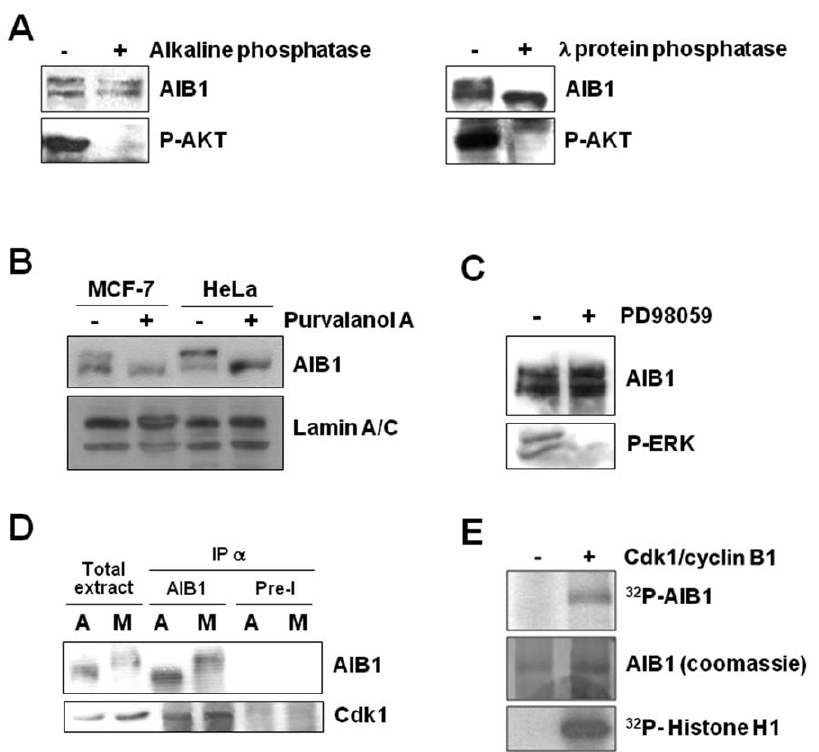
Figure 3. AIB1 is phosphorylated at entry to M phase by Cdk1/cyclin B. (A) Western blot analysis of 30 m g of cleared lysates from nocodazole-arrested HeLa cell which were treated with the indicated phosphatases for 1.5 h at 30 u C. Phospho-Akt antibodies were used as a control of the enzymatic activity. (B) Cells arrested at mitosis with nocodazole were further treated with vehicle alone ( 2 ) or with the Cdk1 inhibitor purvalanol A 10 mM ( + ) during 3 hours. Anti-lamin A/C antibodies were used to control loading. (C) Mitotic cells were treated with the MEK inhibitor PD98059 20 m M ( + ) or with vehicle alone ( 2 ) and cell lysates were analyzed by western blotting with AIB1 antibodies. Phospho-ERK specific antibodies were used as control for the efficiency of the treatment. (D) Western blot analysis of immunoprecipitated complexes using anti-AIB1 antibodies or pre-immune serum (Pre-I) from lysates of asynchronous HeLa cells (A) or from cells arrested with nocodazole (M). (E) Human AIB1 was subcloned in pFASTBac HTa and baculovirus were produced to express the recombinant full-length His6-AIB1 in Sf9 cells using the system BacPak (Clontech). Recombinant protein was purified by standard Ni 2 + -NTA affinity chromatography followed by desalting with a molecular exclusion column. Purified AIB1 (middle panel) was incubated with [ c - 32 P]ATP in the presence ( + ) or absence ( 2 ) of recombinant Cdk1/cyclin B1 for 1 hour at 30 u C (upper panel). Reactions were resolved by SDS-PAGE, the gel was dryed and exposed to an X-ray film. 1 m g of histone H1 (Sigma) was used as a positive control (bottom